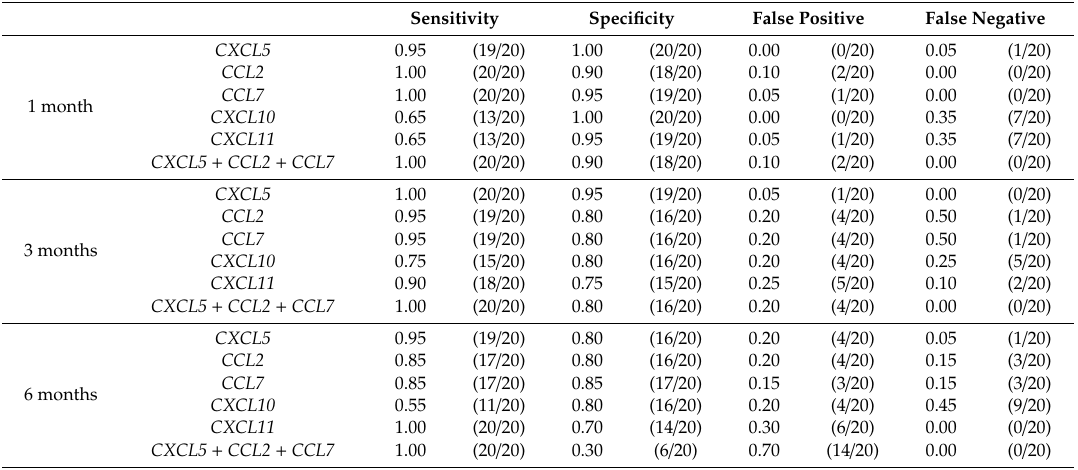
Table 4. Sensitivity and specificity of gene expression of five chemokines in the pulmonary toxicity of nanomaterials.